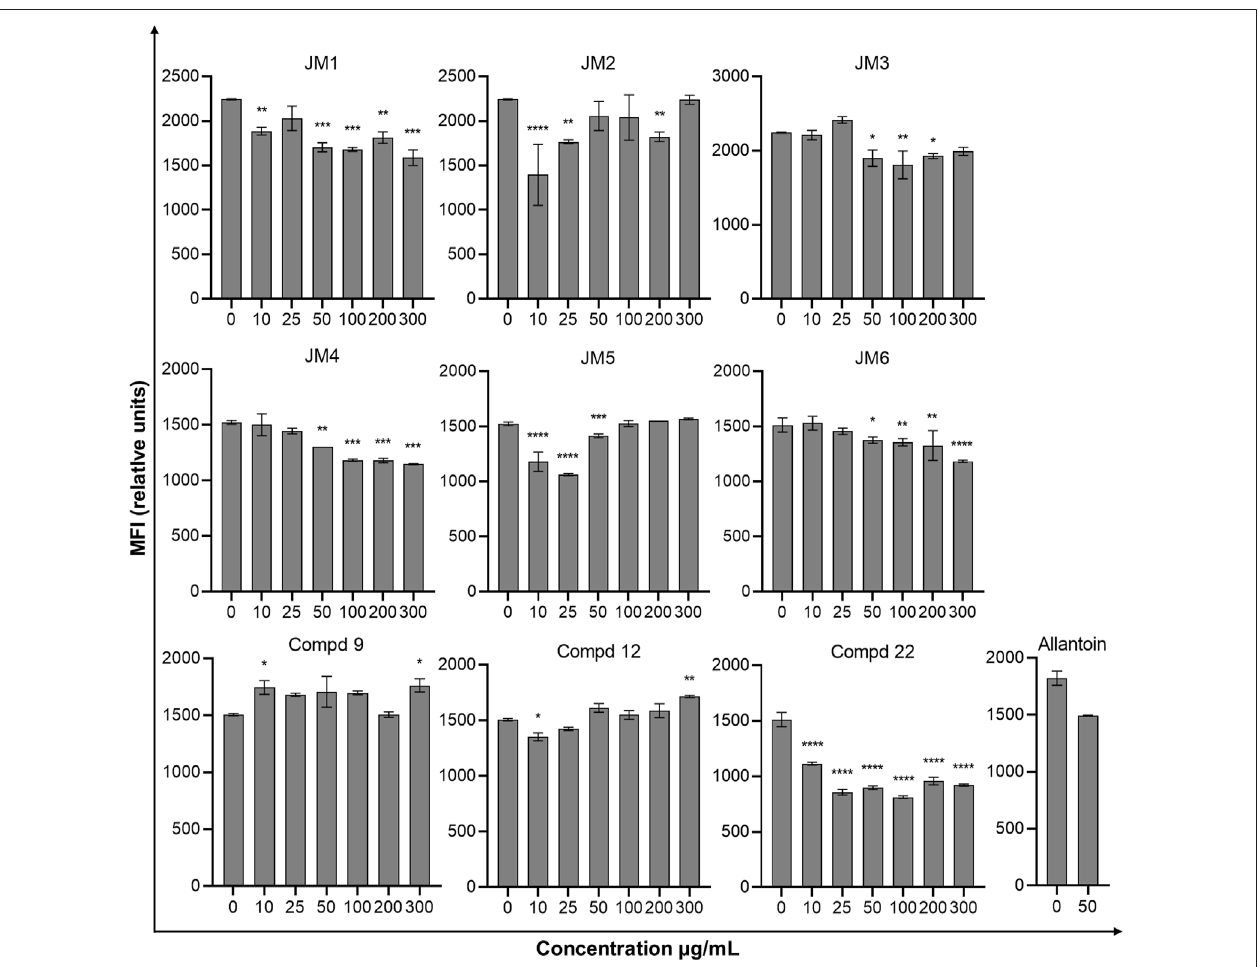
FIGURE 2 | Effect of J. montana extracts ( JM1 – JM6 ) and their main compounds ( 9 , 12 , and 22 ) (10 – 300 μ g/mL) and allantoin (50 μ g/mL) on the collagen type I content in fi broblast cells. Data are expressed as the percentage of the median fl uorescence intensity compared with the control. Data are presented as the median fl uorescence intensity (MFI) from three independent experiments ( n = 3) performed in duplicate. * p < 0.05 versus the control group, ** p < 0.01 versus the control group, *** p < 0.001 versus the control group, **** p < 0.0001 versus the control group.